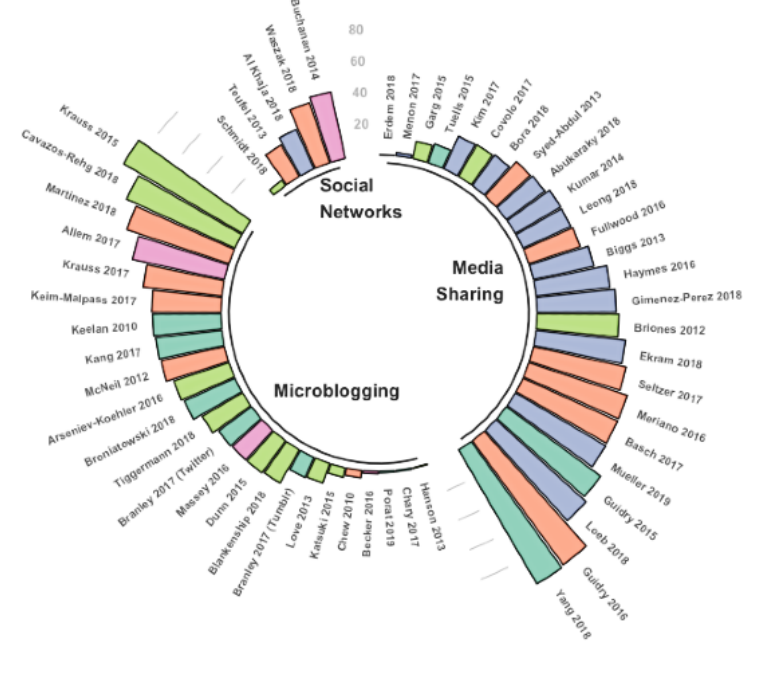
Figure 3. Prevalence of health misinformation grouped by methods and social media